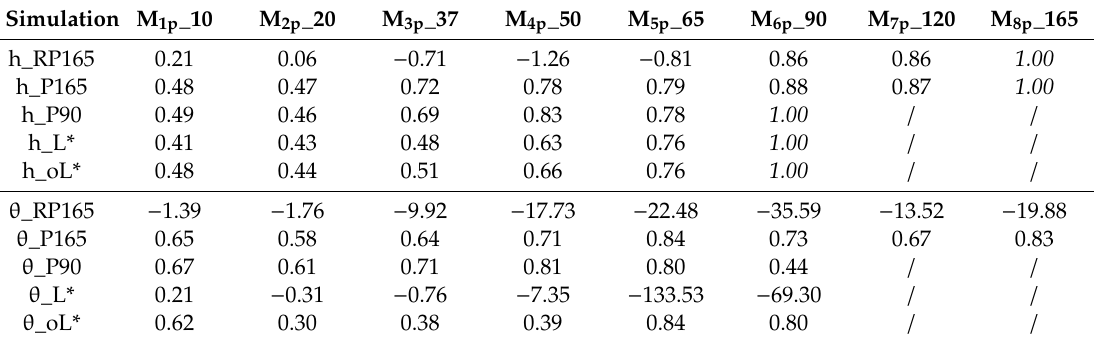
Table 3. E ffi ciency coe ffi cients calculated at each instrumented depth in Field Plot 1 and based on di ff erent optimization procedures using HYDRUS-1D. RP165 for results obtained with the parameters optimized with RetC, P165 for results obtained with the parameters optimized with HYDRUS-1D on the 165 cm deep profile; P90 for results obtained by applying the parameters optimized for the 165 cm deep profile to the 90 cm deep profile; L* for results obtained by applying the mean optimized parameters from the six lysimeters; oL*, the same as L* but for saturated water content values ( θ s * ) again optimized for each soil